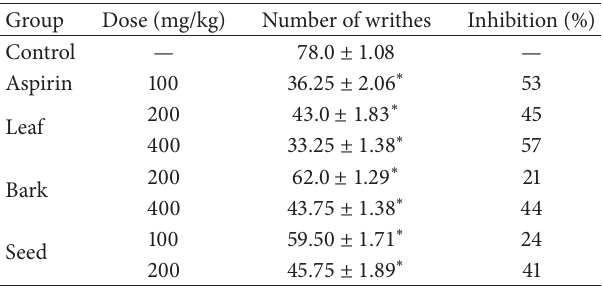
Values are mean of observations from six mice ( 𝑛 = 6 ) ± SEM. Significantly different from control at ∗ 𝑃 < 0.001